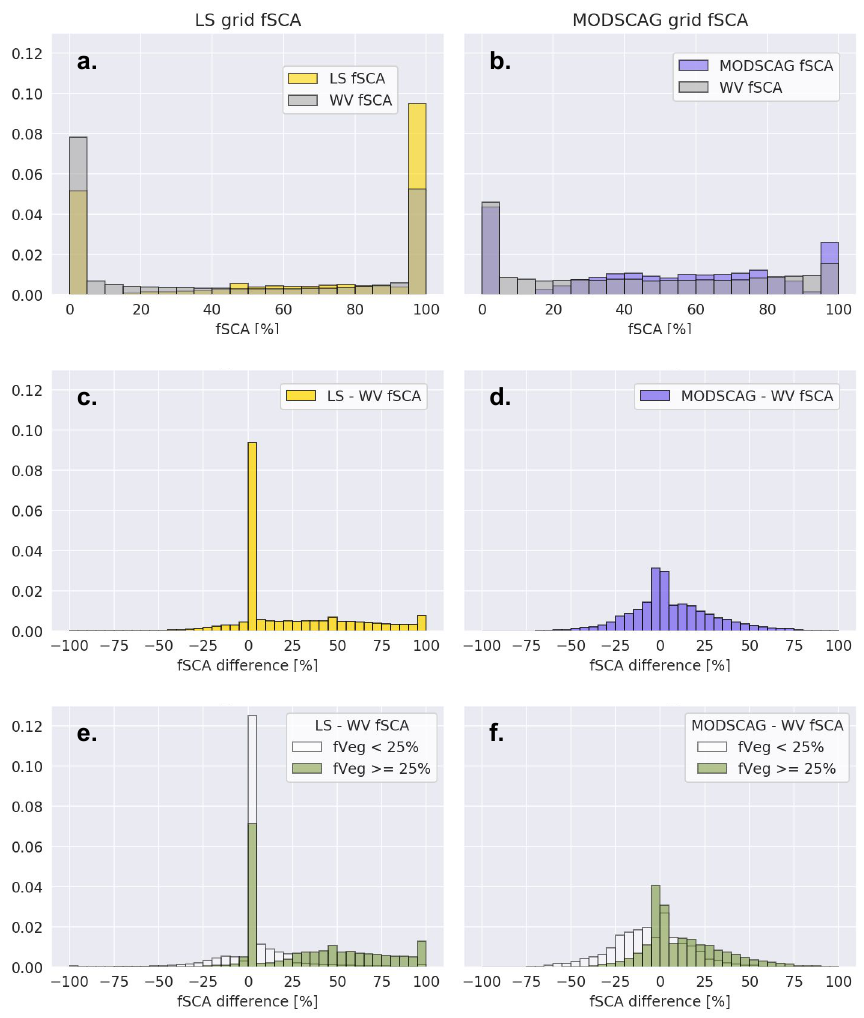
Figure 8. Aggregated statistics for all fractional snow-covered area (fSCA) comparisons (Supplementary Table S4 and Supplementary Figure S3). Top row shows histograms of fSCA for ( a ) Landsat grid and ( b ) MODIS grid. Middle row shows histograms of per-pixel fSCA difference for ( c ) WV fSCA subtracted from Landsat fSCA in Landsat grid, and ( d ) WV fSCA subtracted from MODSCAG fSCA in MODIS grid. Bottom row shows corresponding histograms of fSCA difference values when separated by vegetation density (WV fVeg) for ( e ) Landsat and ( f ) MODSCAG. Bin size is 5% fSCA for all panels and all histograms were normalized by bin height so that the integral sums to